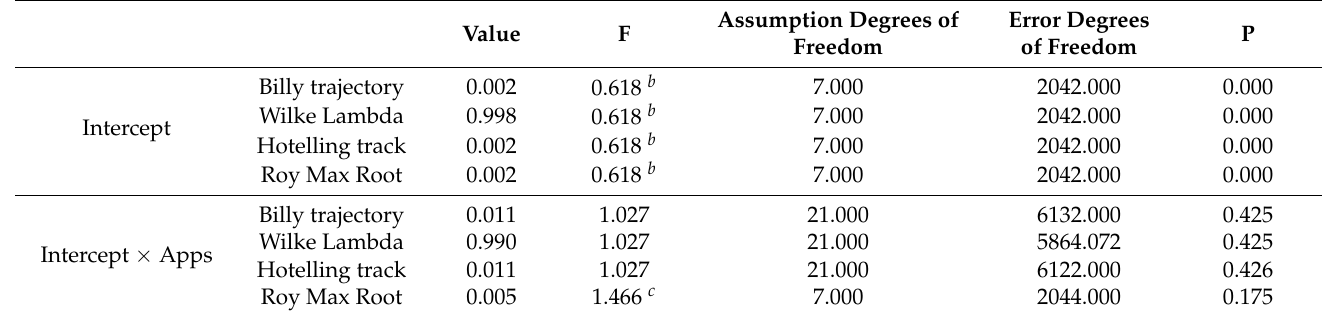
Table 8. ANOVA for electrode × APP.